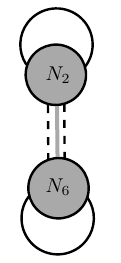
Figure 7 . Quiver associated to the ATD